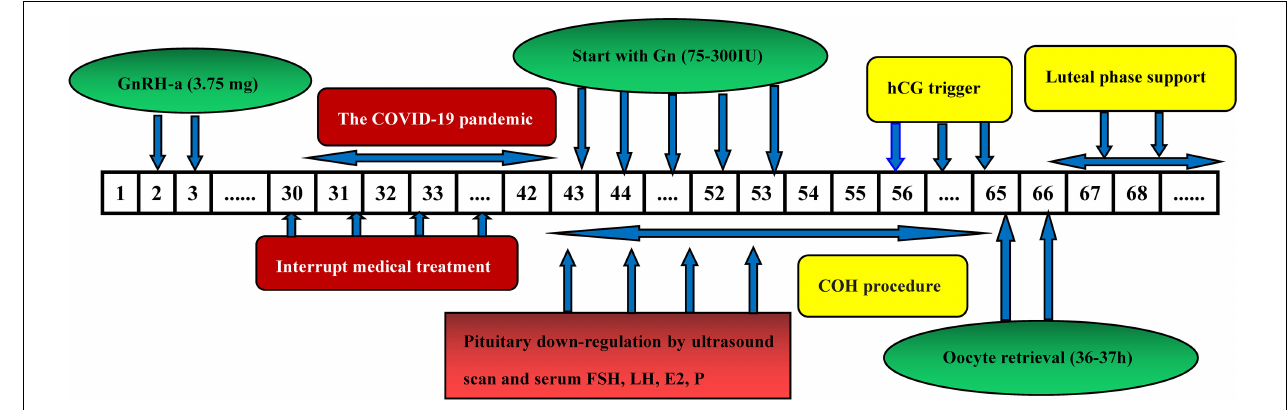
FIGURE 3 | The flow chart of prolonged pituitary down-regulation of EFLL protocol.